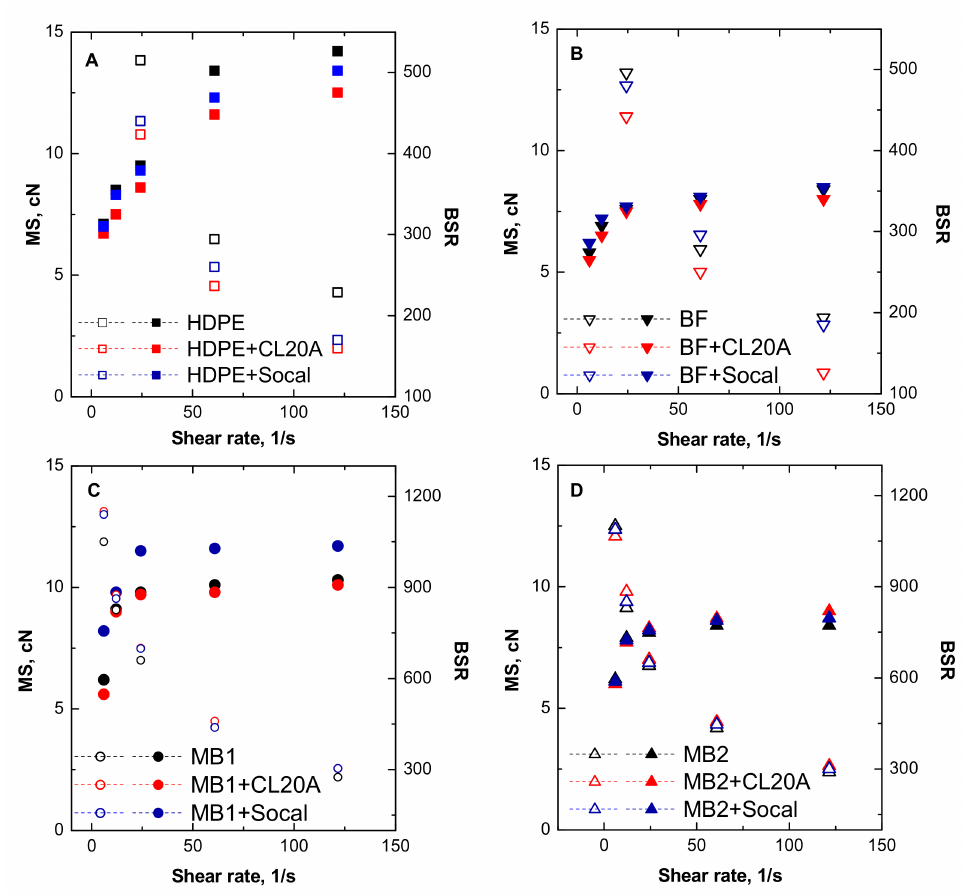
Figure 3. Melt strength (MS—filled symbols) and breaking stretching ratio (BSR—blank symbols) as a function of shear rate for all investigated materials: ( A ) HDPE-based systems, ( B ) BF-based systems, ( C ) MB1-based systems and ( D ) MB2-based